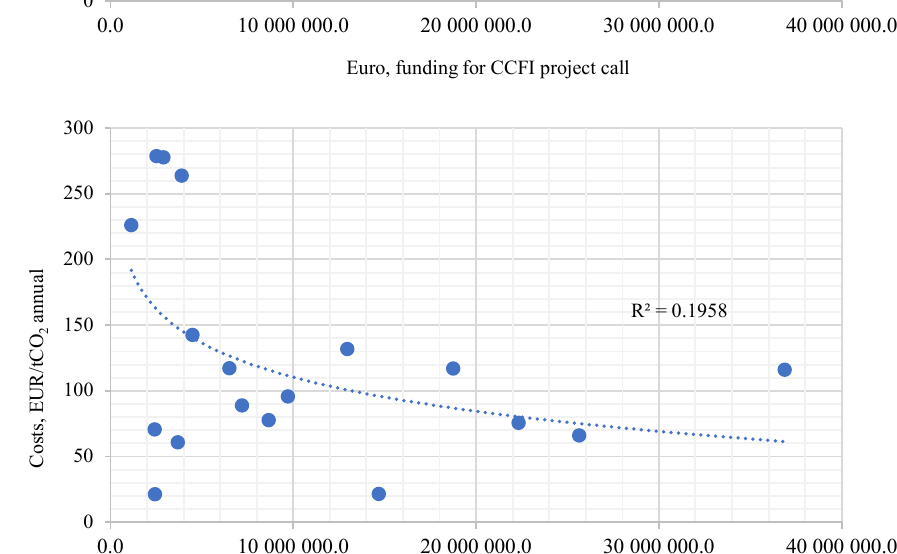
Fig. 5. Relationships between CCFI competition group average costs of one CO 2 tonne reduction to competition funding